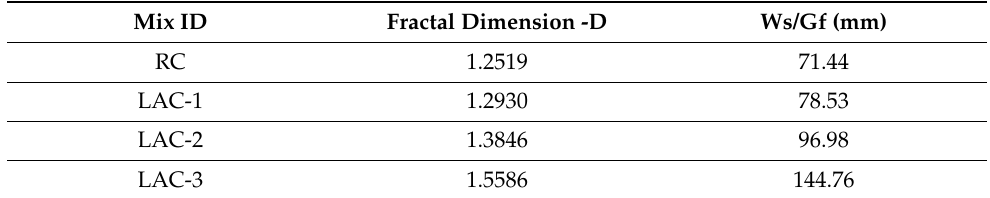
Figure 10. Fractal dimensions of the mixes. Table 2. Fractal dimensions vs. Ws/Gf values.